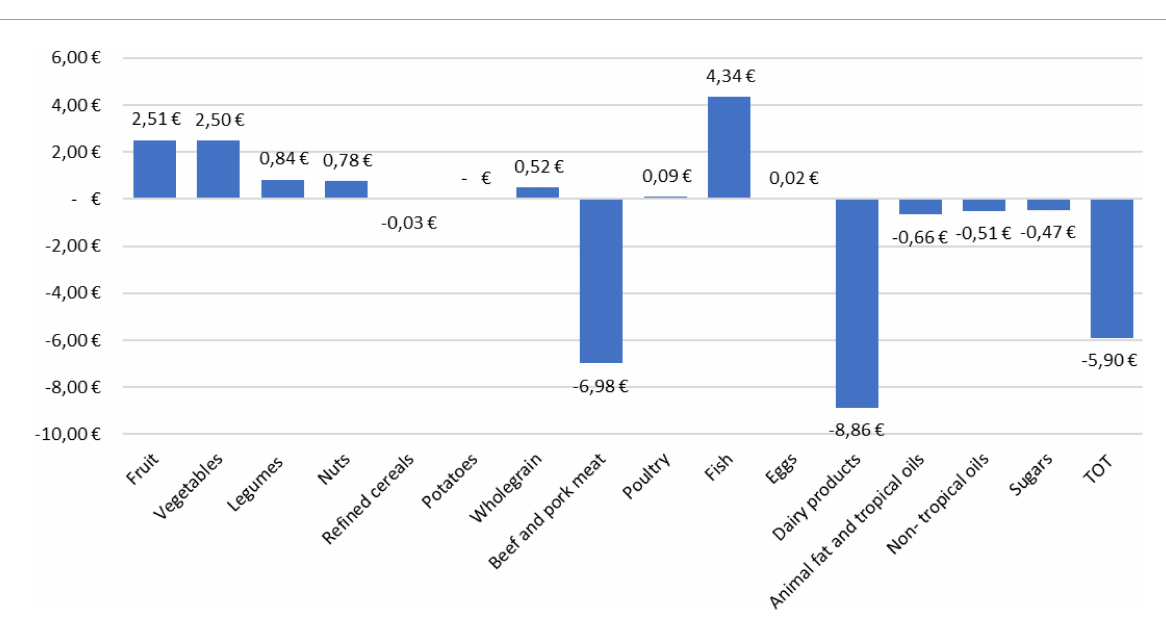
FIGURE5 Changes in the expenditure for the various foods according to the desirable diet compared to the current Italian